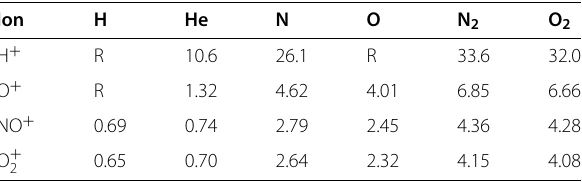
Table 2 The collision frequnecy coefficients C in × 10 10 for nonresonant ion-neutral